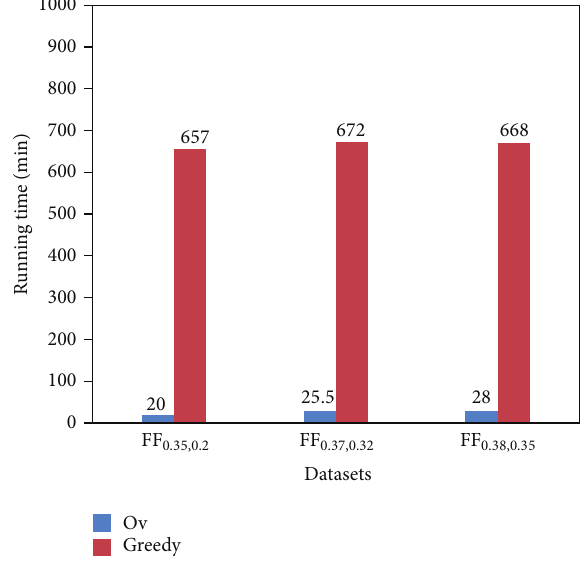
Figure 3: Time efficiency analysis.